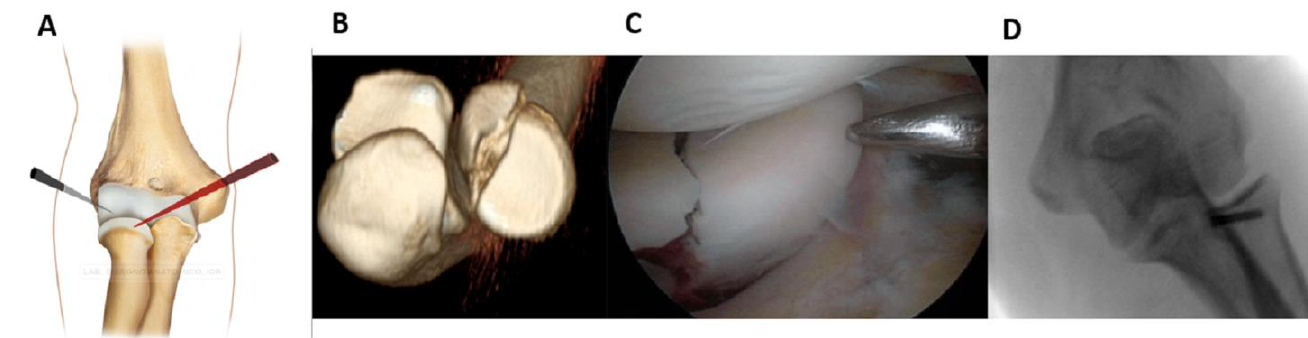
Figure 3. For the medial half fractures, the working position AM was more appropriate; the field was viewed from the anterolateral portal and the cannula was inserted through the anteromedial portal ( A ). ( B ): Pre-operative 3D CT scan showing the fracture. ( C ): Intraoperative image of fracture fixation. ( D ): Control x-ray. Table 2. Description of arthroscopic working position to address fixation of radial head